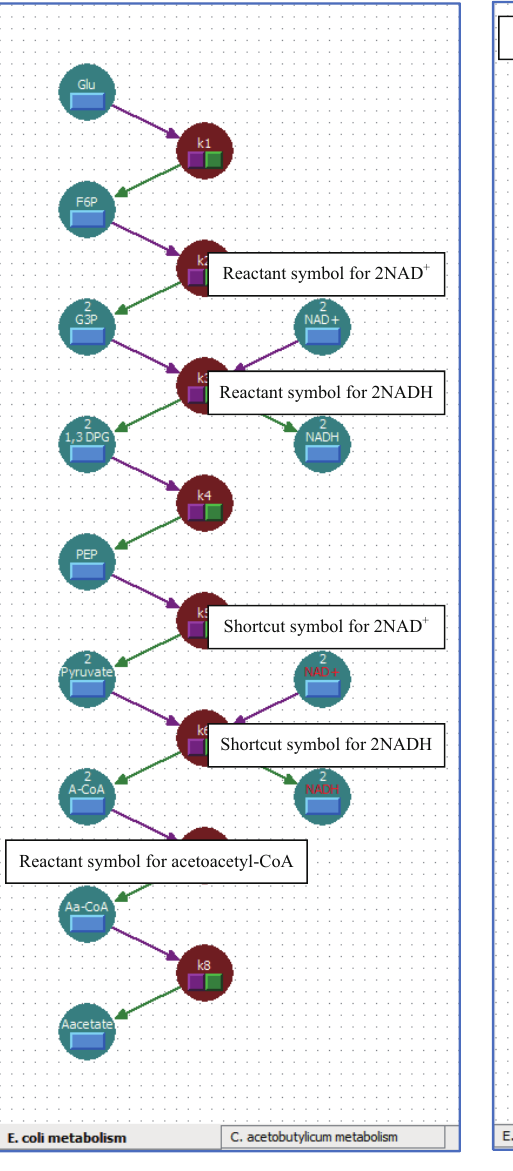
Figure 9. Reaction scheme corresponding to Figure 8 created using WinBEST-KIT. Reactant symbols and shortcut symbols with unique stoichiometric coefficients can be connected between Escherichia coli and Clostridium acetobutylicum metabolisms in different